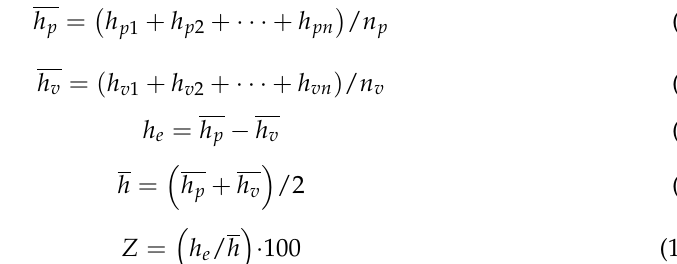
Figure 3. The variation of r -values versus strain energy density for the uniform elongation regime of tensile test specimens cut in different directions.